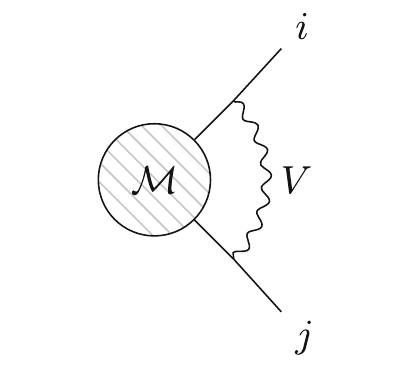
Fig. 1 Feynman diagram contributing to double-logarithmic Sudakov